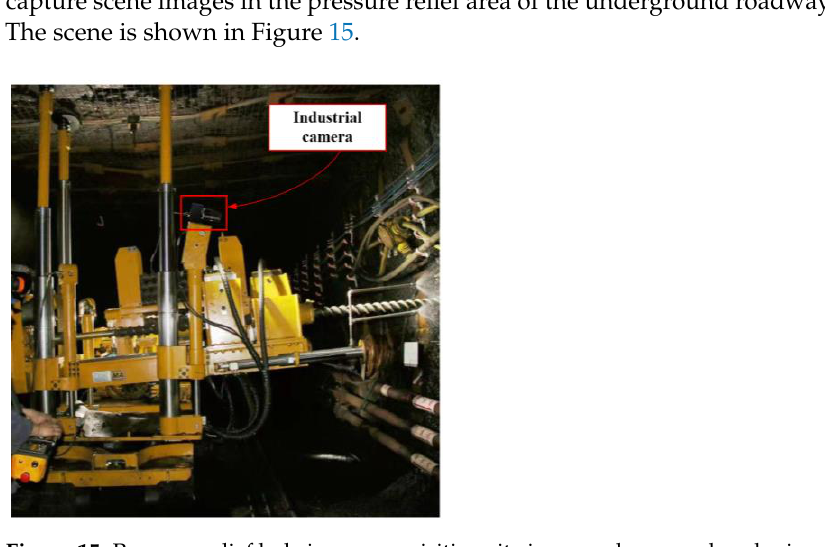
Figure 15. Pressure relief hole image acquisition site in an underground coal